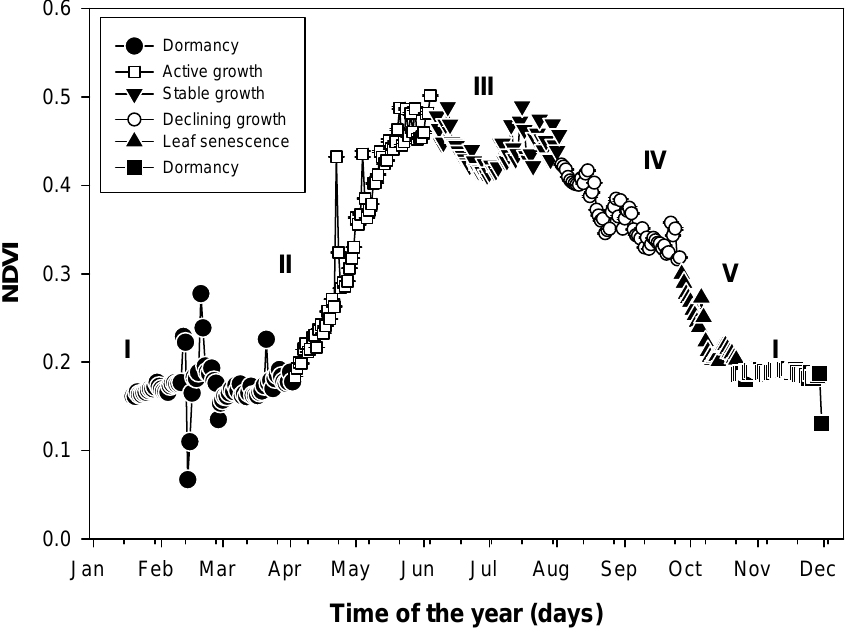
Figure 2. Time series of average midday (11:30–13:30 h) NDVI values of a single greasewood plant at the Spring Valley 1 site. Data were acquired for the period from January 19 to November 30, 2007. I: dormancy phase (January 19–April 2); II: active growth and canopy development phase (April 3–June 6); III: full canopy development and stable physiological status phase (June 7–August 2); IV: water limitation and stress response phase (August 3–September 26); V: leaf senescence phase